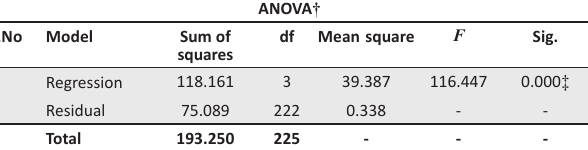
TABLE 6b: Moderation analysis.